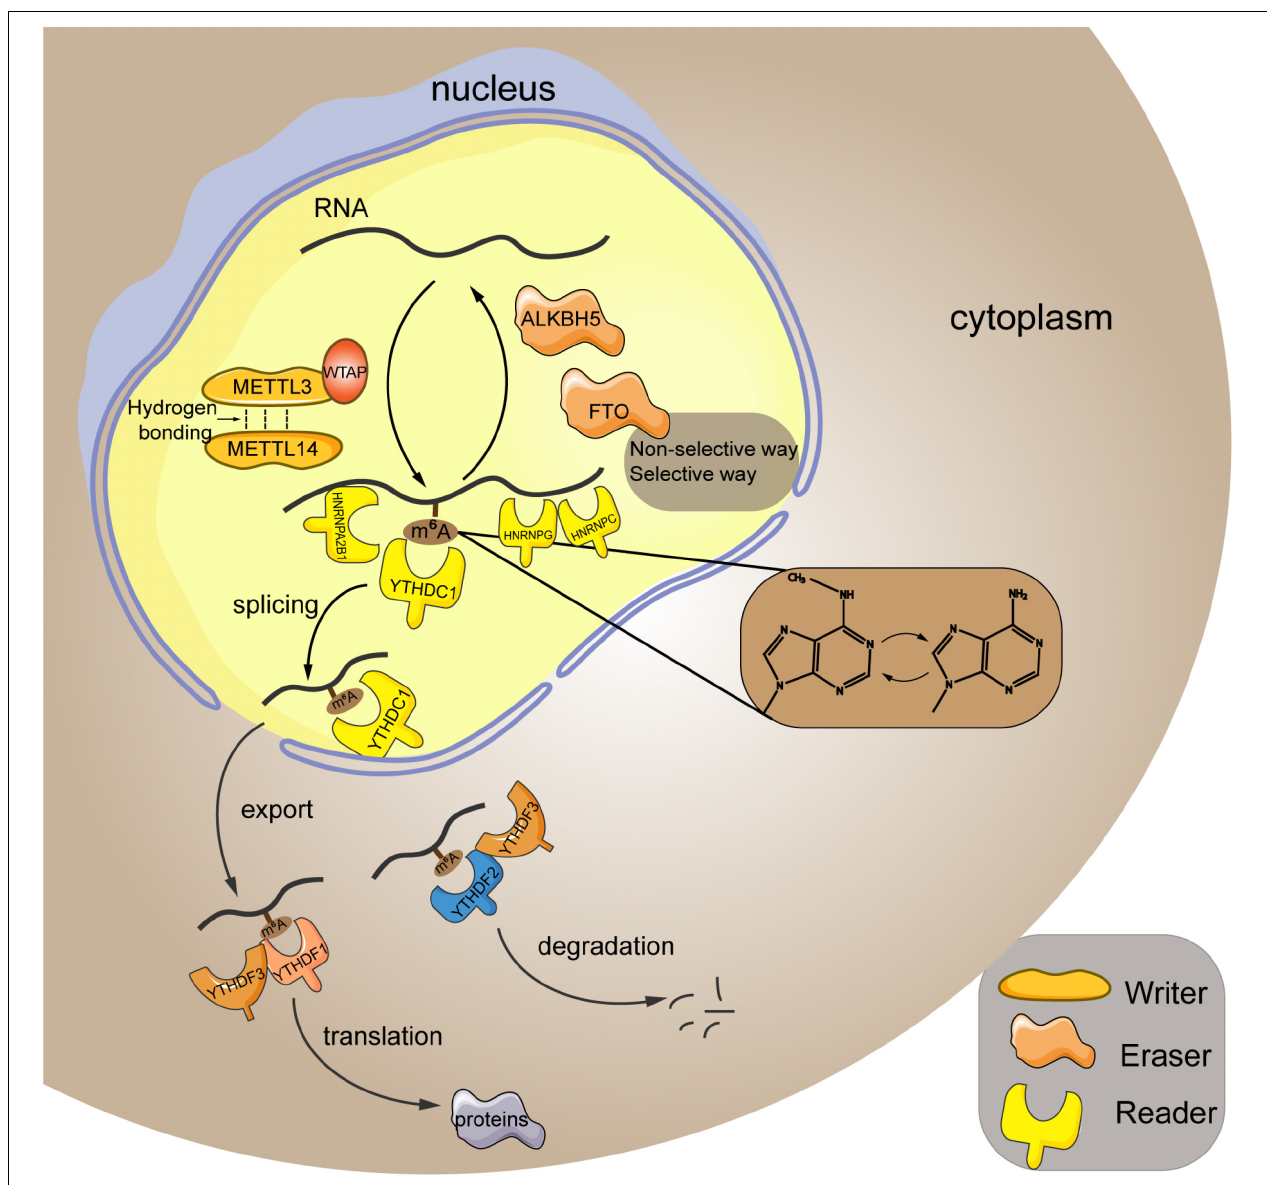
FIGURE 1 | Mechanism of m 6 A RNA modification. M 6 A modification is a reversible process mediated by its regulatory proteins, including the writers (MELTT3, METTL14, WTAP, etc.), erasers (FTO, ALKBH5, etc.), and readers (YTHDF1, YTHDF2, YTHDF3, etc.). METTL3, methyltransferase-like 3; METTL14, methyltransferase-like 14; WTAP, Wilms tumor 1-associated protein; FTO, fat mass and obesity-associated protein; ALKBH5, alkB homolog 5; YTHDF1, YTH domain family; member 1; HNRNPA2B1, heterogeneous nuclear ribonucleoprotein A2B1; HNRNPC, heterogeneous nuclear ribonucleoprotein C; HNRNPG, heterogeneous nuclear ribonucleoprotein